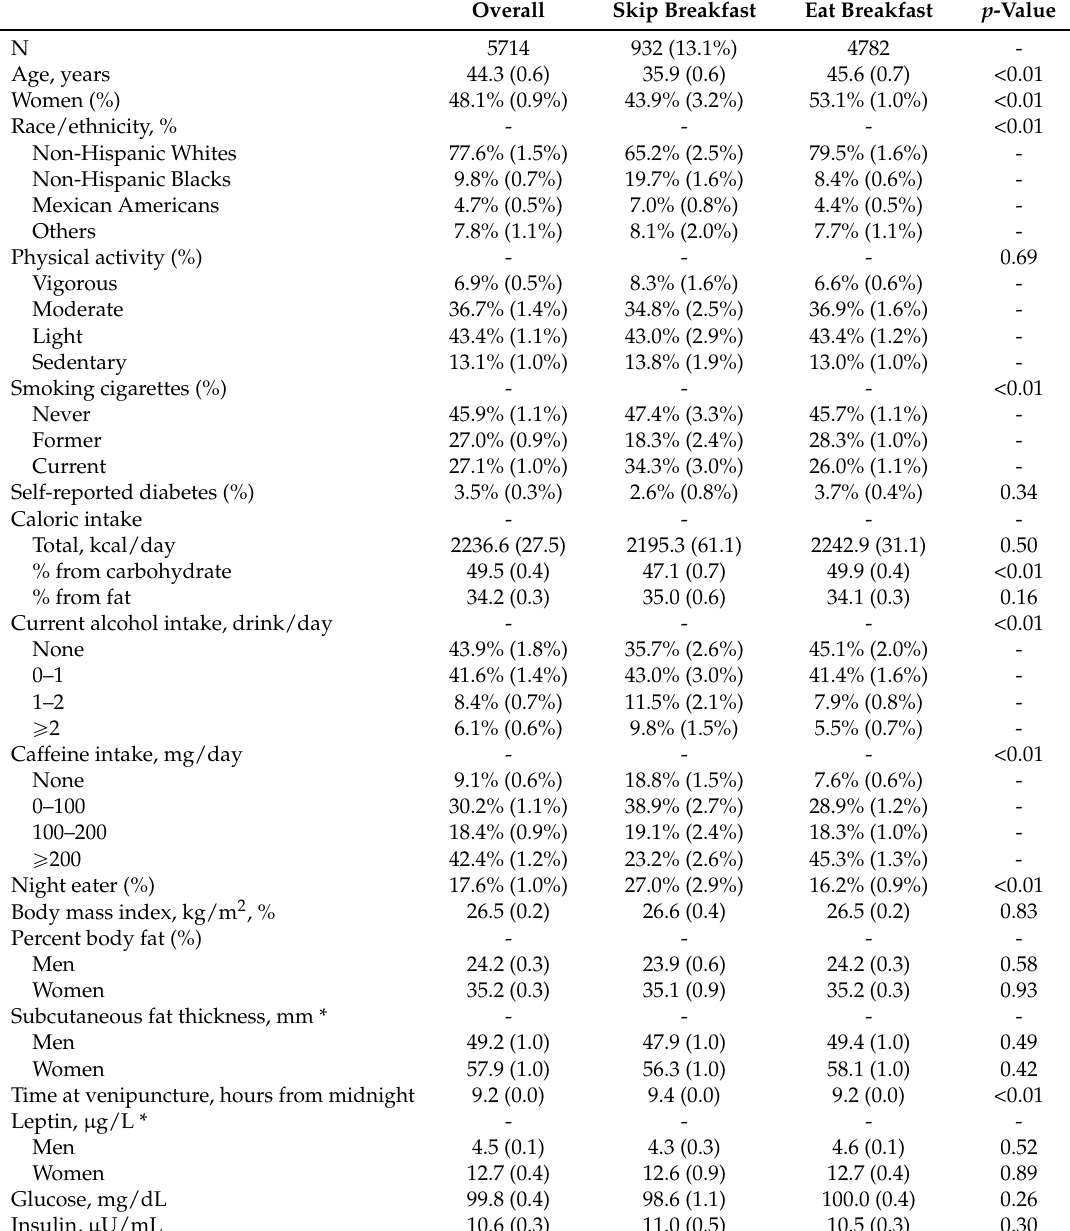
Table 1. Characteristics of participants by skipping breakfast, the National Health and Nutrition Examination Survey (NHANES) III,